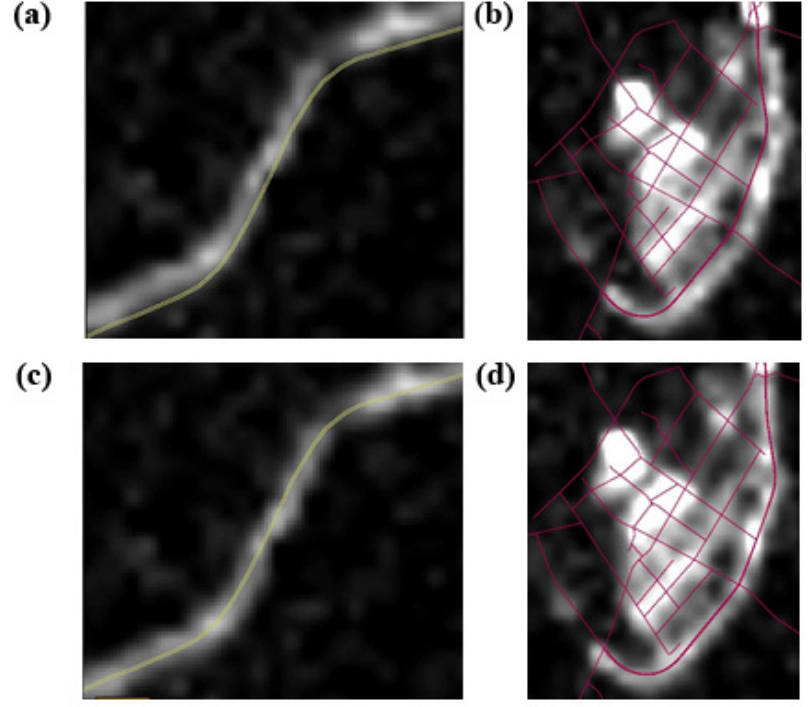
Figure A2. Luojia 1-01 image before ( a , b ) and after ( c , d ) the geometric correction.